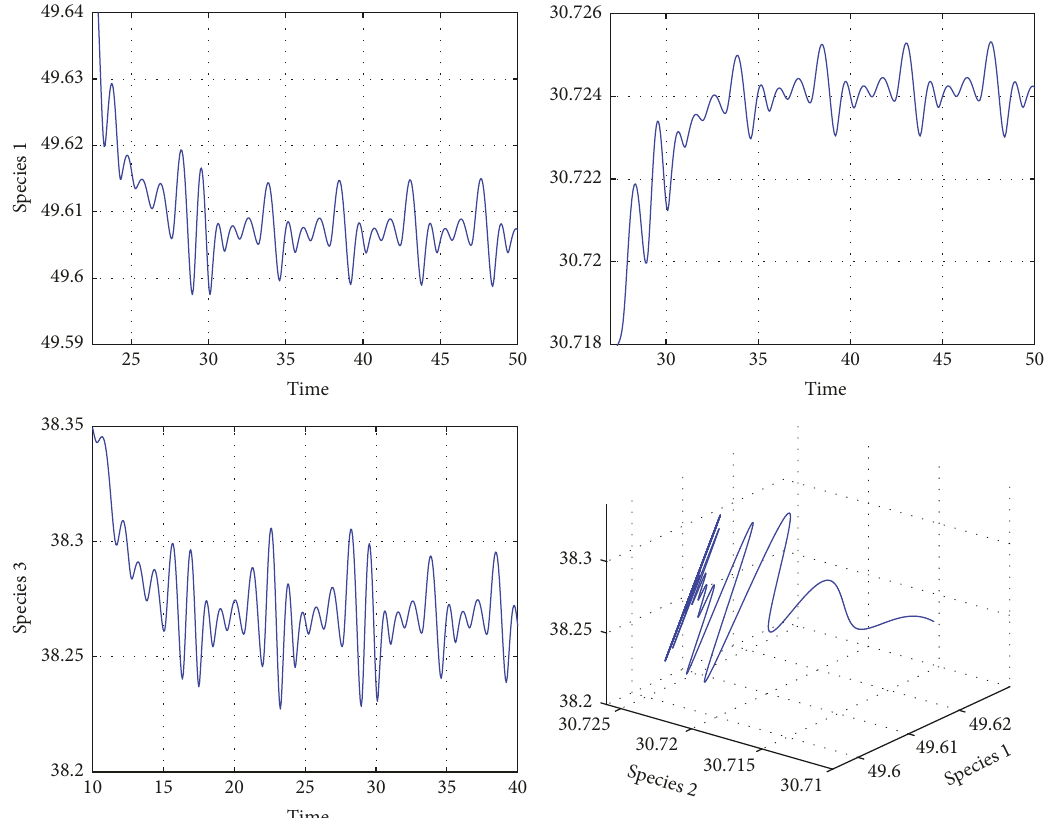
Figure 4: Dynamical behaviors and phase space trajectories of the three marine